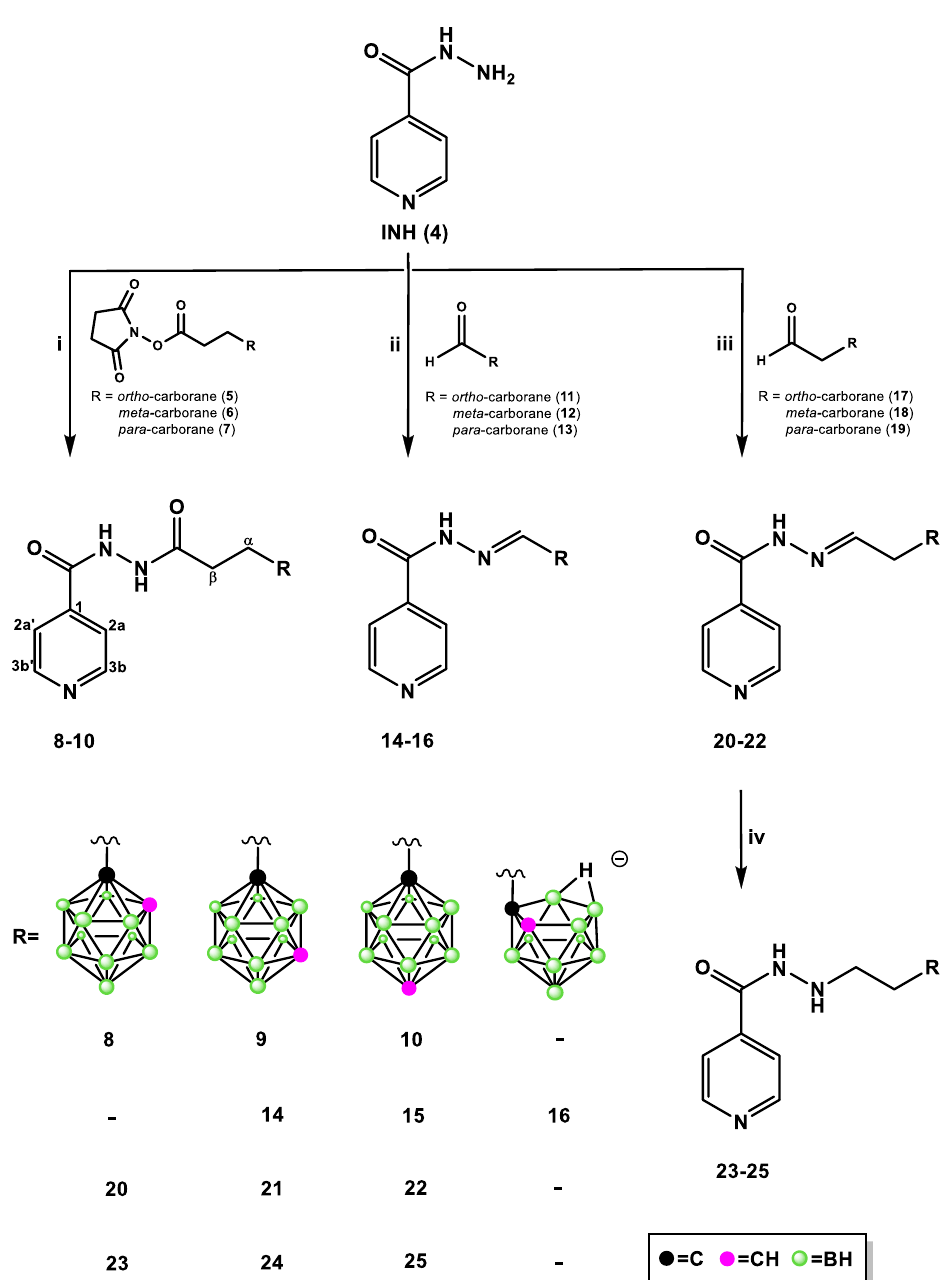
Figure 3. INH-carborane hybrids: ( i ) 8: 3-(1,2-dicarba- closo -dodecaboran-1-yl)propionic acid N -succinimidyl ester ( 5 ), EtOH abs , 4 days, 40 °C; 9: 3-(1,7-dicarba- closo -dodecaboran-1-yl)propionic acid N -succinimidyl ester ( 6 ), EtOH abs , 3 days, room temperature (RT); 10: 3-(1,12-dicarba- closo -dodecaboran-1-yl)propionic acid N -succinimidyl ester ( 7 ), EtOH abs , 3 days, RT; ( ii ) 14: 1-formyl-1,7-dicarba- closo -dodecaborane ( 12 ), EtOH abs , 20 h, 40 °C; 15: 1-formyl-1,12-dicarba- closo -dodecaborane (13), EtOH abs , 96 h, 40 °C; 16: 1-formyl-1,2-dicarba- closo -dodecaborane ( 11 ), ethyl acetate anh , 24 h, 40 °C; ( iii ) 20: 2-(1,2-dicarba- closo -dodecaboran-1-yl)ethanal (17), EtOH abs , 12 h, 35 °C; 21: 2-(1,7- dicarba- closo -dodecaboran-1-yl)ethanal ( 18 ), EtOH abs , 12 h, RT; 22: 2-(1,12-dicarba- closo -